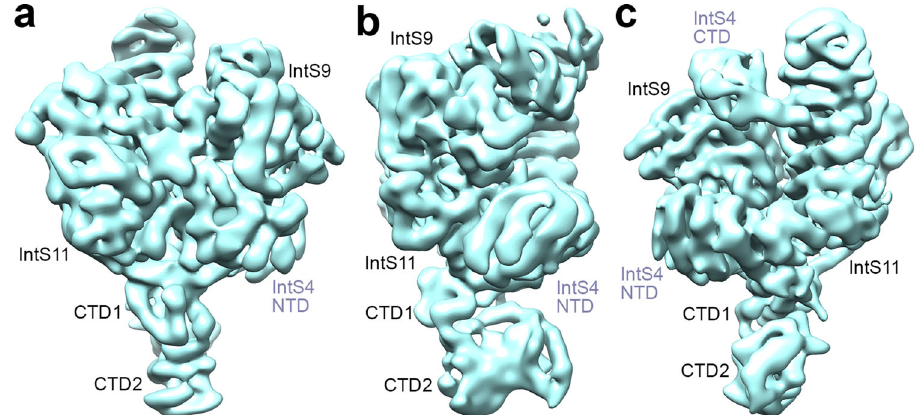
Fig. 2 | Weak EM density for some regions of the Drosophila IntS4-IntS9-IntS11 complex (ICM). a Cryo-EM density of the IntS4-IntS9-IntS11 complex low-pass fi l- tered to 7Å resolution, and viewed after 90° ( b ) and 180° ( c ) rotation around the vertical axis. Weak EM density for CTD2 of IntS9 and IntS11 and residues beyond